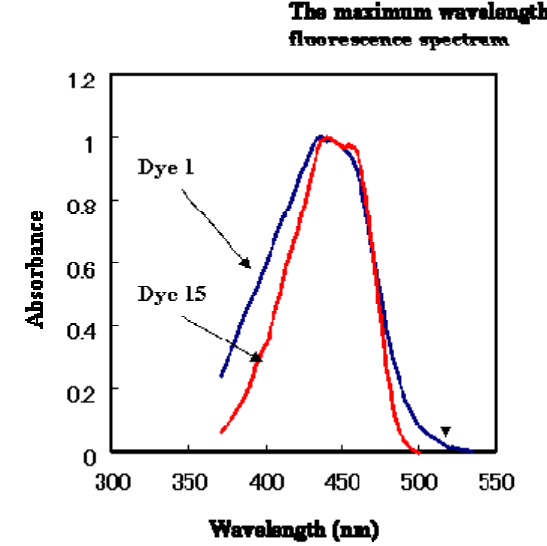
Figure 10. The absorption spectra of anthraquinone dye 1 and coumarin dye 15 (in ethyl